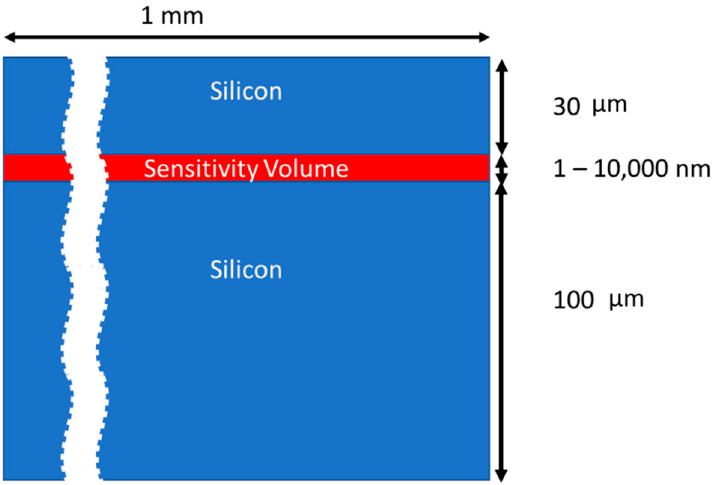
Figure 1. The geometry setup in this study. The silicon is with natural isotope abudence, density is 2330 mg/cm 3 and mean extiation potetial I = 173